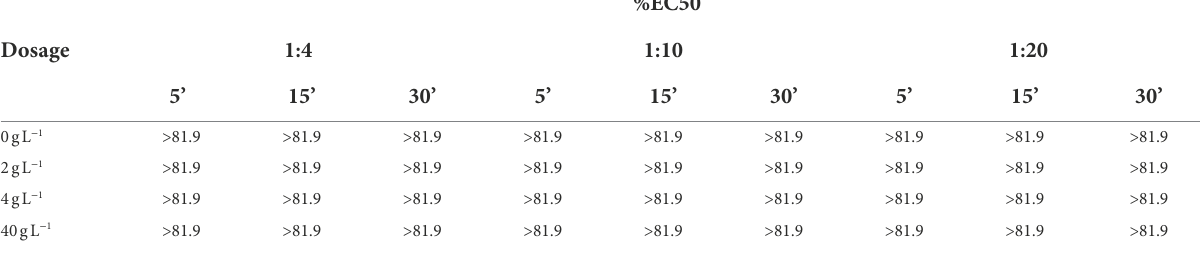
TABLE 3 Vibrio fischeri light emission test results obtained at three different reading times for three different dilutions of leachates.